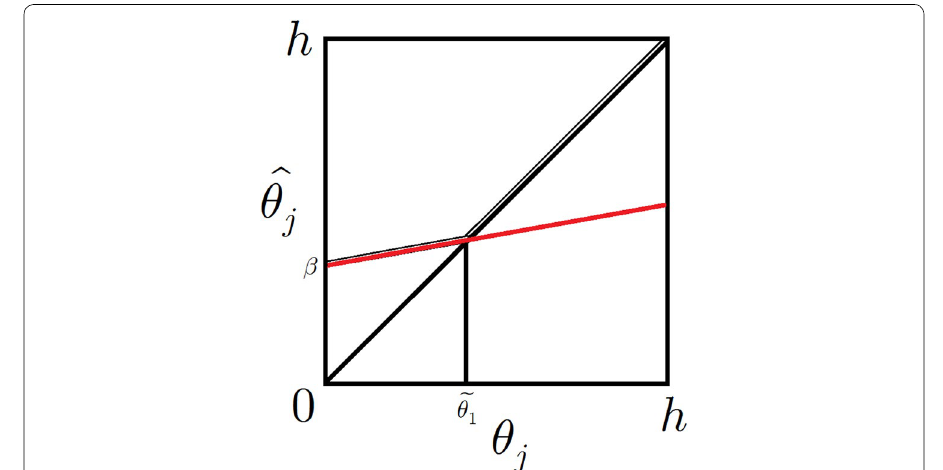
Fig. 4 Horizontal axis represents potential productivity of individuals, and vertical axis represents realized productivity. Entrepreneurs with higher productivity than ˜ θ 1 will realize their productivity along with 45° line. But the others will follow the red line. Kinked double line will be the frontier for